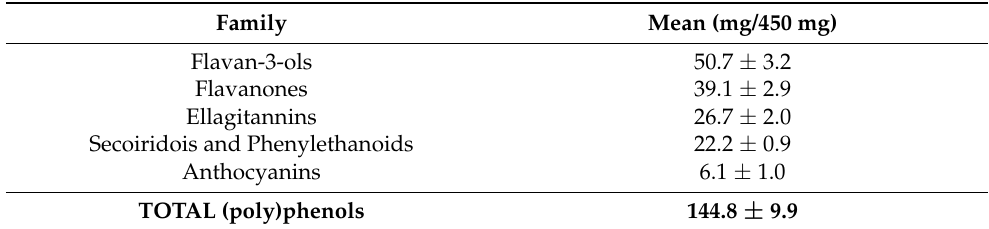
Table 2. Internal HPLC analysis and quantification of the main (poly)phenolic families occurring in the supplement. Values are reported as mean (mg/450 mg) ± SD ( n = four different production batches of the